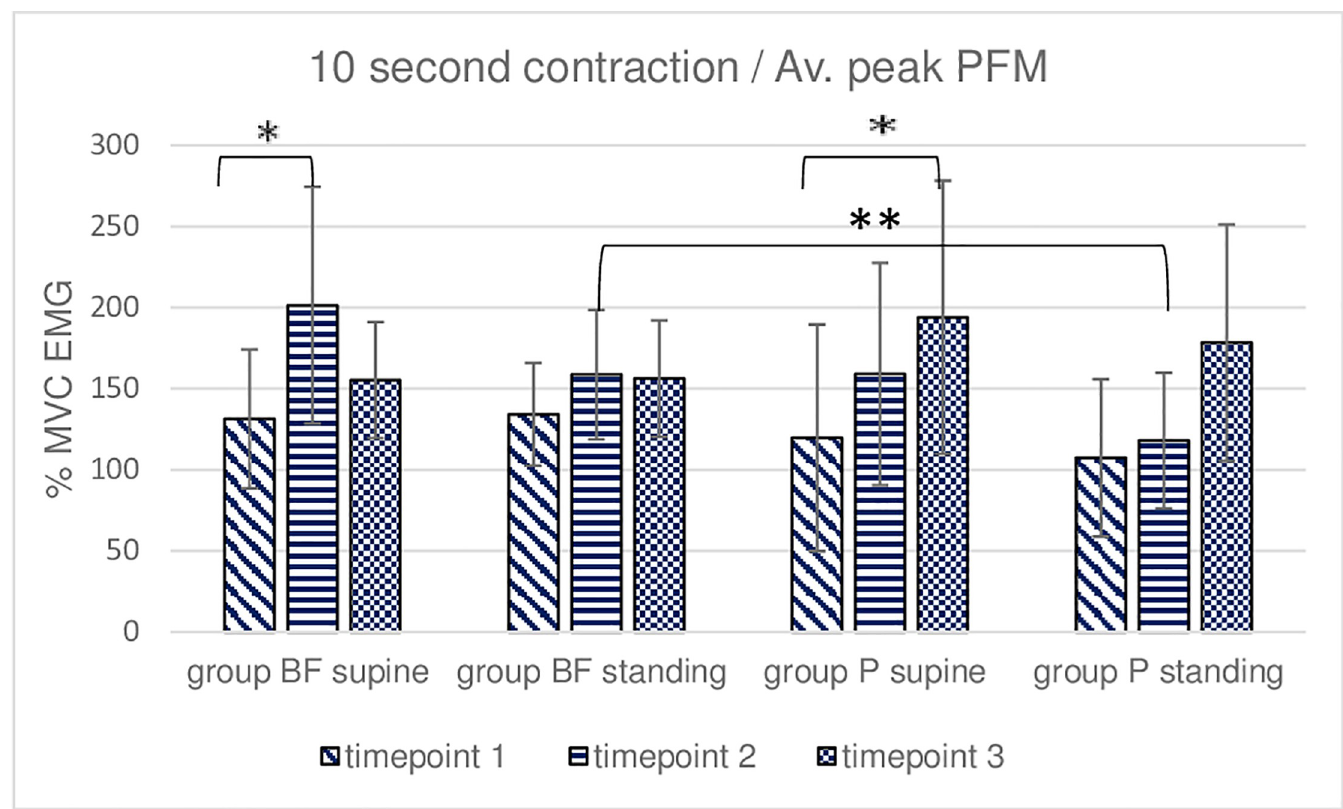
Fig 6. Intra- and intergroup analysis of sEMG average peak %MVC amplitudes of the 5 repetitions of 10-second voluntary contraction of pelvic floor muscles; p � Post-hoc Friedman’s rank sum test; p �� Mann- Whitney U